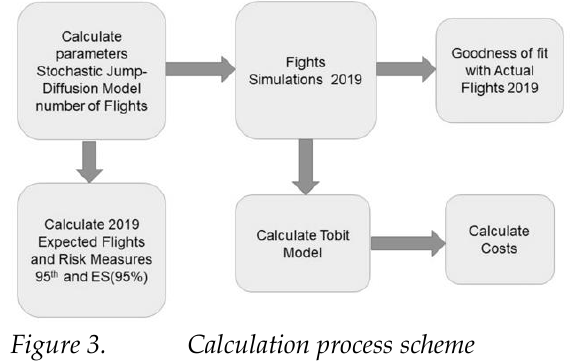
Calculation process scheme